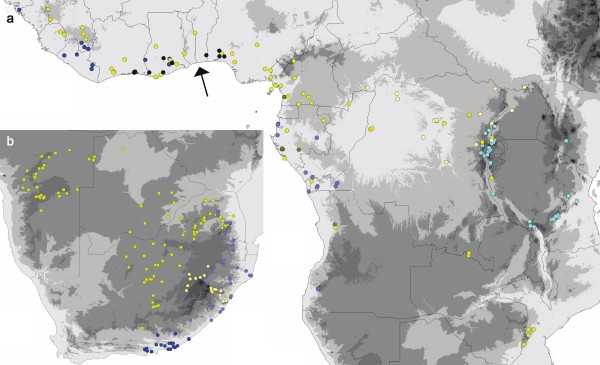
Distribution of species in the Coccinia barteri clade and the C. quinqueloba clade. a Distribution of species in the Coccinia barteri clade. Dark blue = C. longicarpa, deep blue = C. keayana, pale blue = C. heterophylla, light blue = C. mildbraedii, bright yellow = C. barteri morphs, dark yellow = C. racemiflora, pale yellow = C. subsessiliflora. The arrow marks the Dahomey Gap. b Distribution of species in the quinqueloba group. Dark blue = C. quinqueloba, pale blue = C. mackenii, bright yellow = C. sessilifolia, pale yellow = C. hirtella.